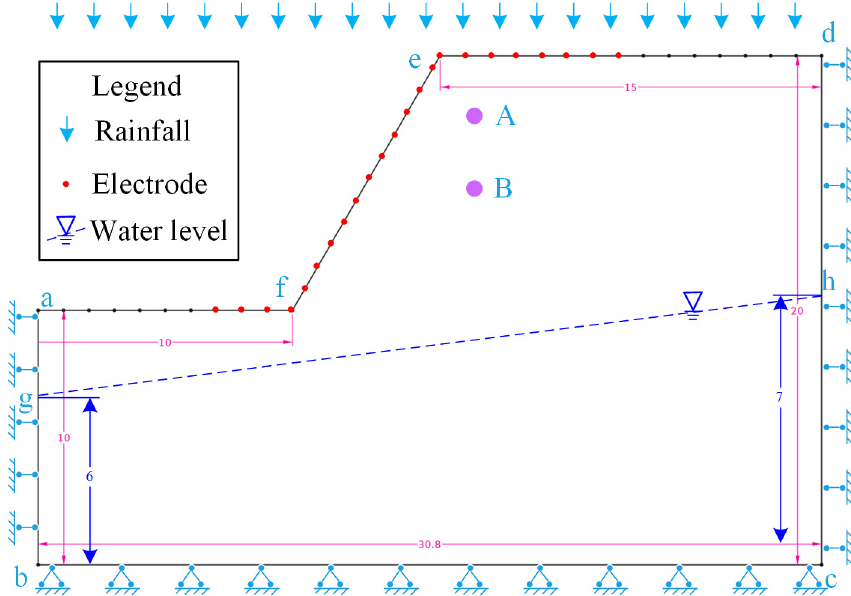
Figure 2. Slope geometry and boundary conditions setup for the used model (unit: m). Table 1. Geotechnical parameters of experimental model.